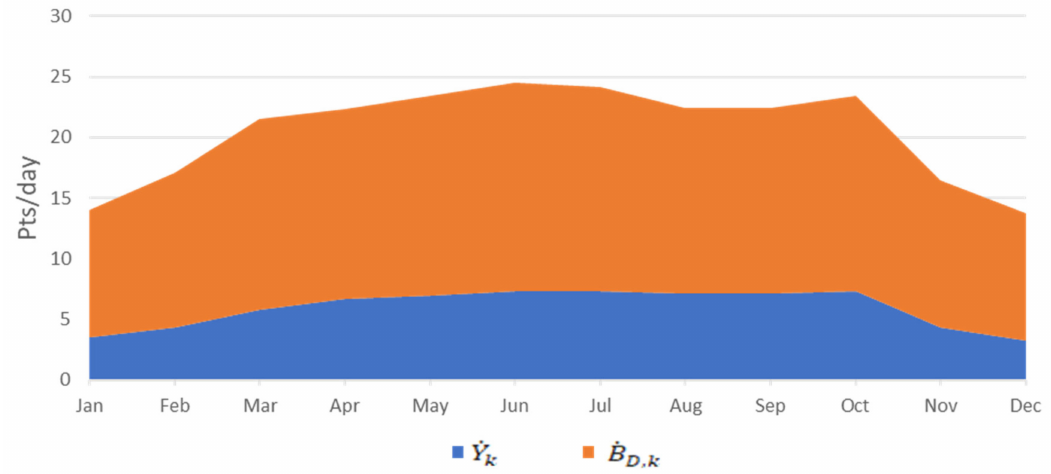
Figure 5. Total environmental impact of TEES as the sum of the burdens dealing with components and exergy destructions during the